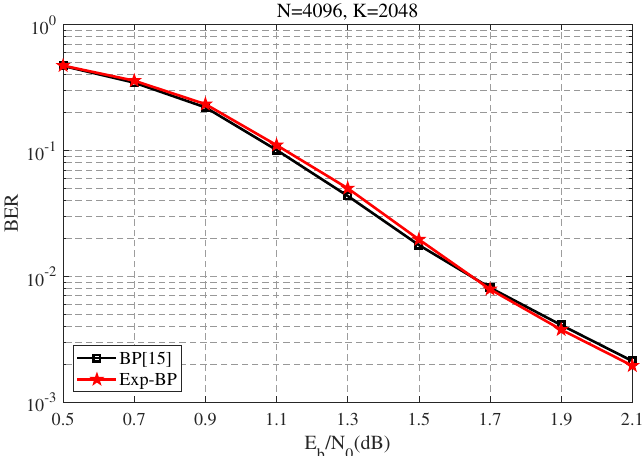
Figure 5. The BER performance of different algorithms with N = 4096.